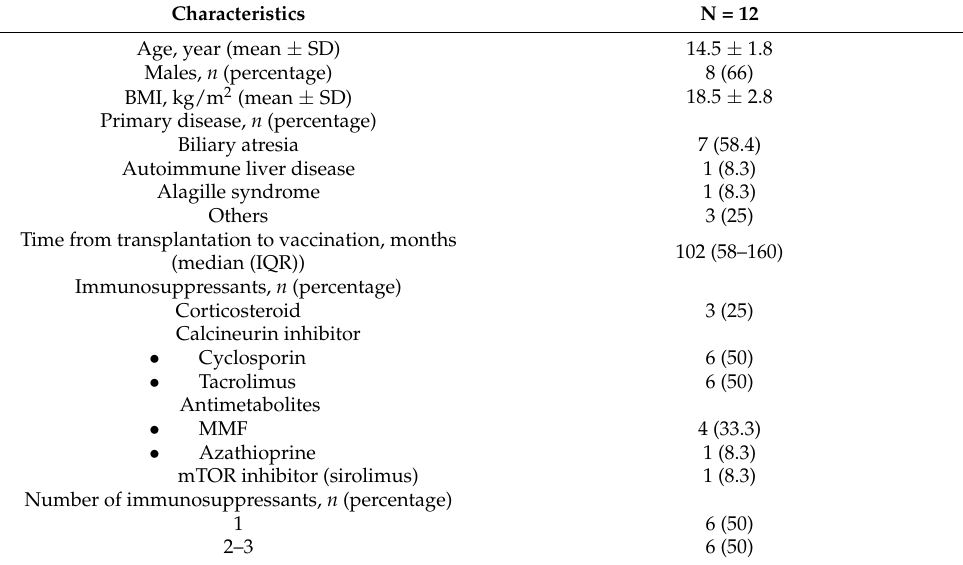
Table 1. Characteristics of liver transplant